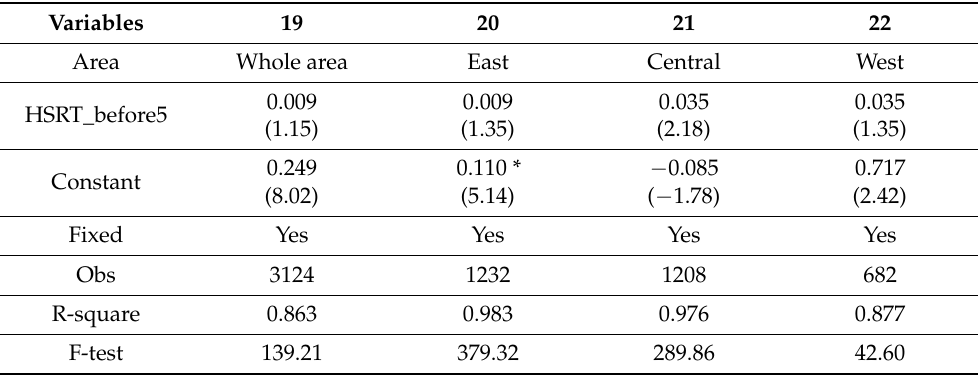
Table 6. Placebo test results of the DID